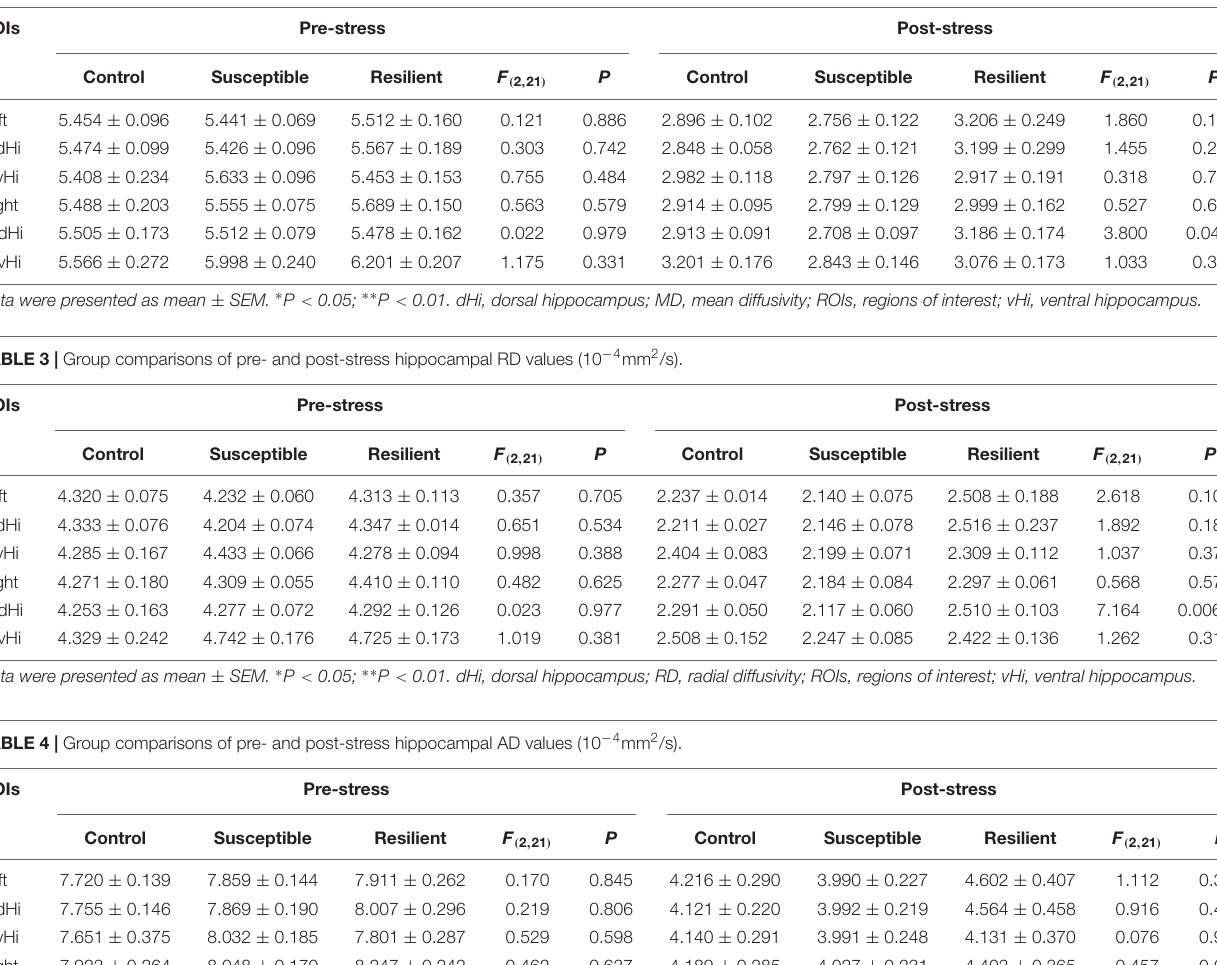
TABLE 2 | Group comparisons of pre- and post-stress hippocampal MD values (10 − 4 mm 2 /s). ROIs Pre-stress Post-stress Control Susceptible Resilient F ( 2 , 21 ) P Control Susceptible Resilient F ( 2 , 21 ) P